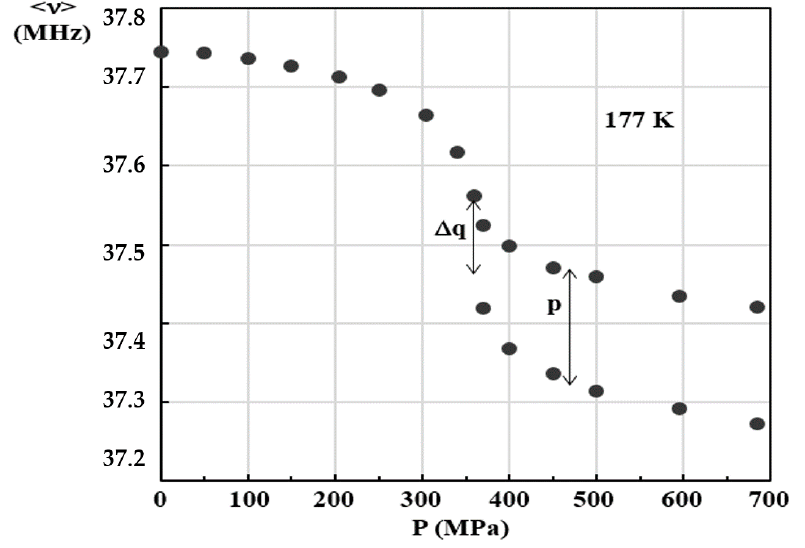
Figure 11. Pressure evolution of high-frequency chlorine Nuclear Quadrupolar Resonance (NQR) lines at 177 K.